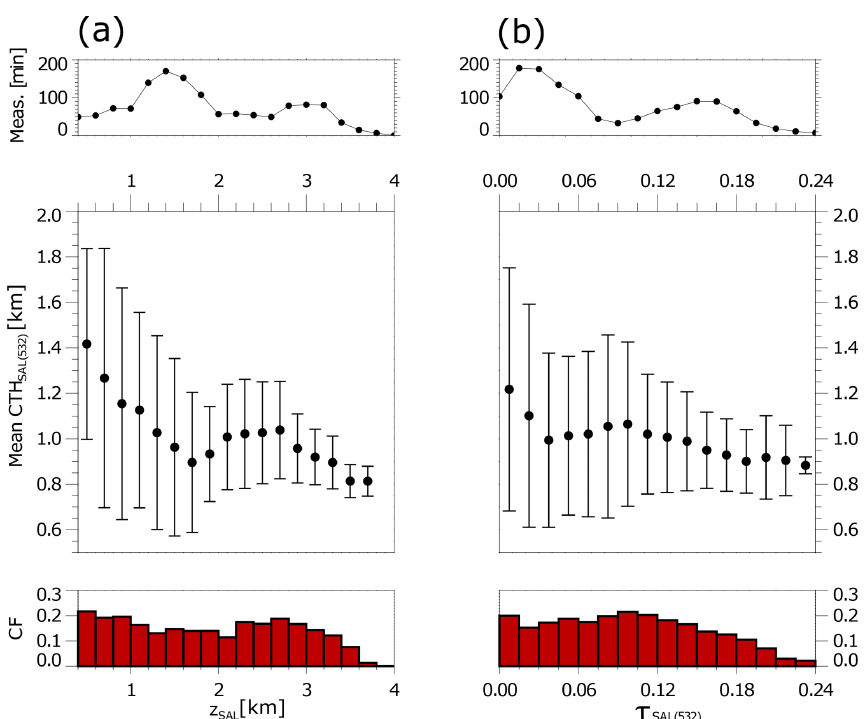
Figure 8. (a) Mean cloud top heights (middle) and cloud fraction (bottom) of clouds detected below Saharan dust layers as a function of Saharan dust layer vertical extent ( (cid:49)z SAL ) – bin interval: 0.2km. (b) Mean cloud top heights (middle) and cloud fraction (bottom) of clouds detected below Saharan dust layers as a function of Saharan dust layer optical depth ( τ SAL ( 532 ) ) at 532nm wavelength – bin interval: 0.015. Bars mark respective standard deviations of mean cloud top heights (1 σ ). The uppermost graphs in (a) and (b) illustrate summed measurement times in each